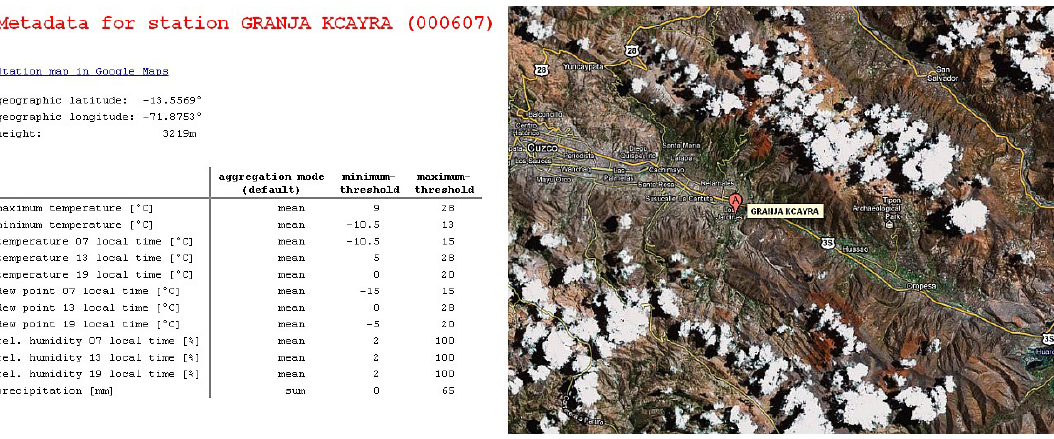
Figure 4. Metadata in the PACC data portal, here for the Station Granja Kcayra. The metadata includes a link to Google Earth, with the geographic location of each station. The thresholds for plausible values are also